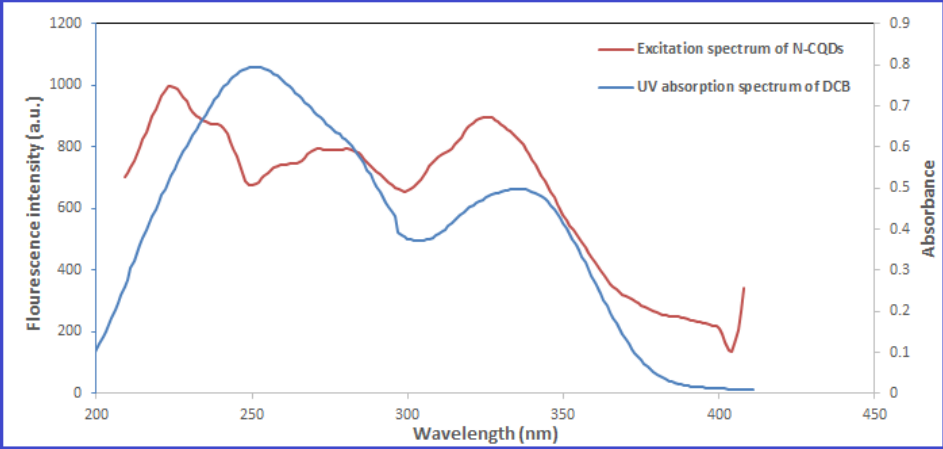
Figure 6. A co-plot of the excitation spectrum of the N-doped CQDs and the absorption spectrum of DCB (20.0 µg/mL).